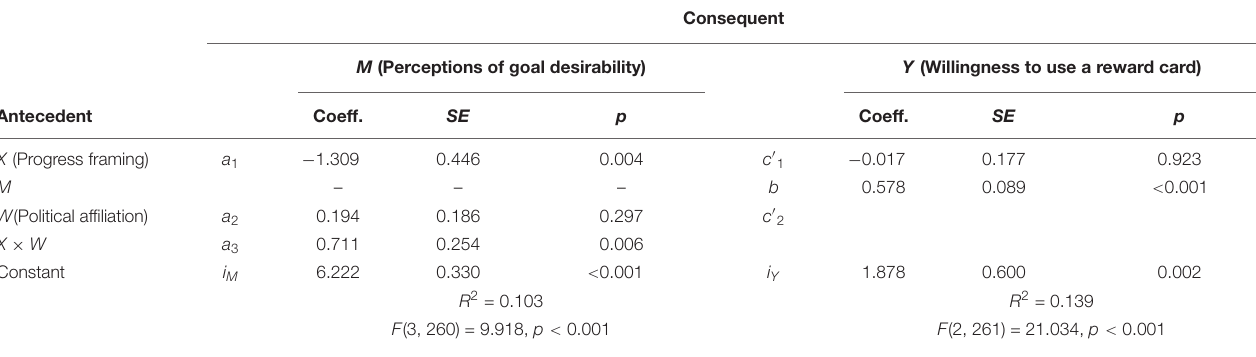
TABLE 1 | Perceptions of goal desirability mediate the effects of progress framing on intention to participate in the waste reduction drive for Republicans, but not for Democrats. Consequent M (Perceptions of goal desirability) Y (Willingness to use a reward card) Antecedent